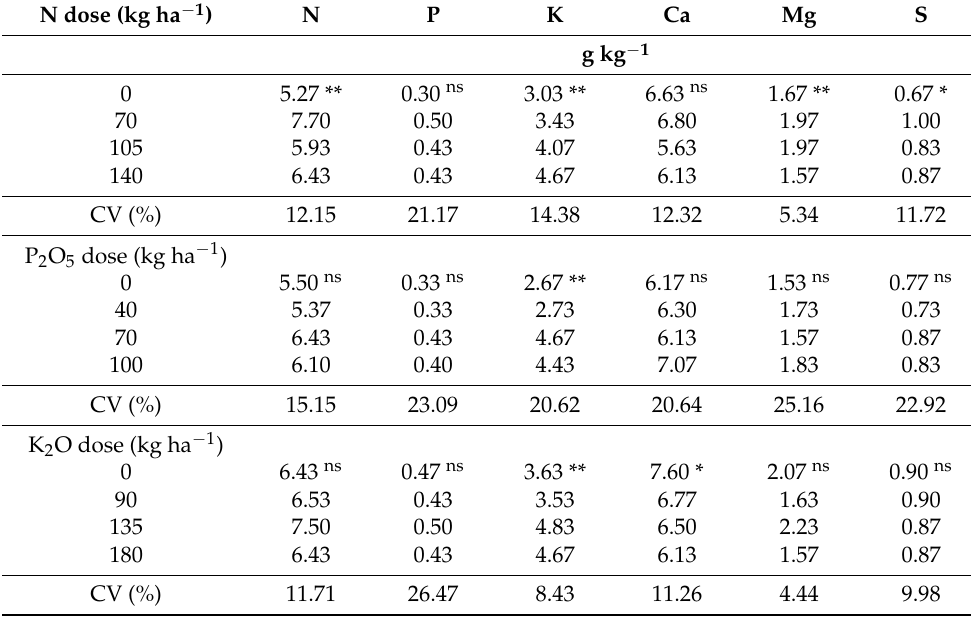
Table 3. Macronutrient contents in eucalyptus leaf litter as a function of residual dose of N, P 2 O 5 and K 2